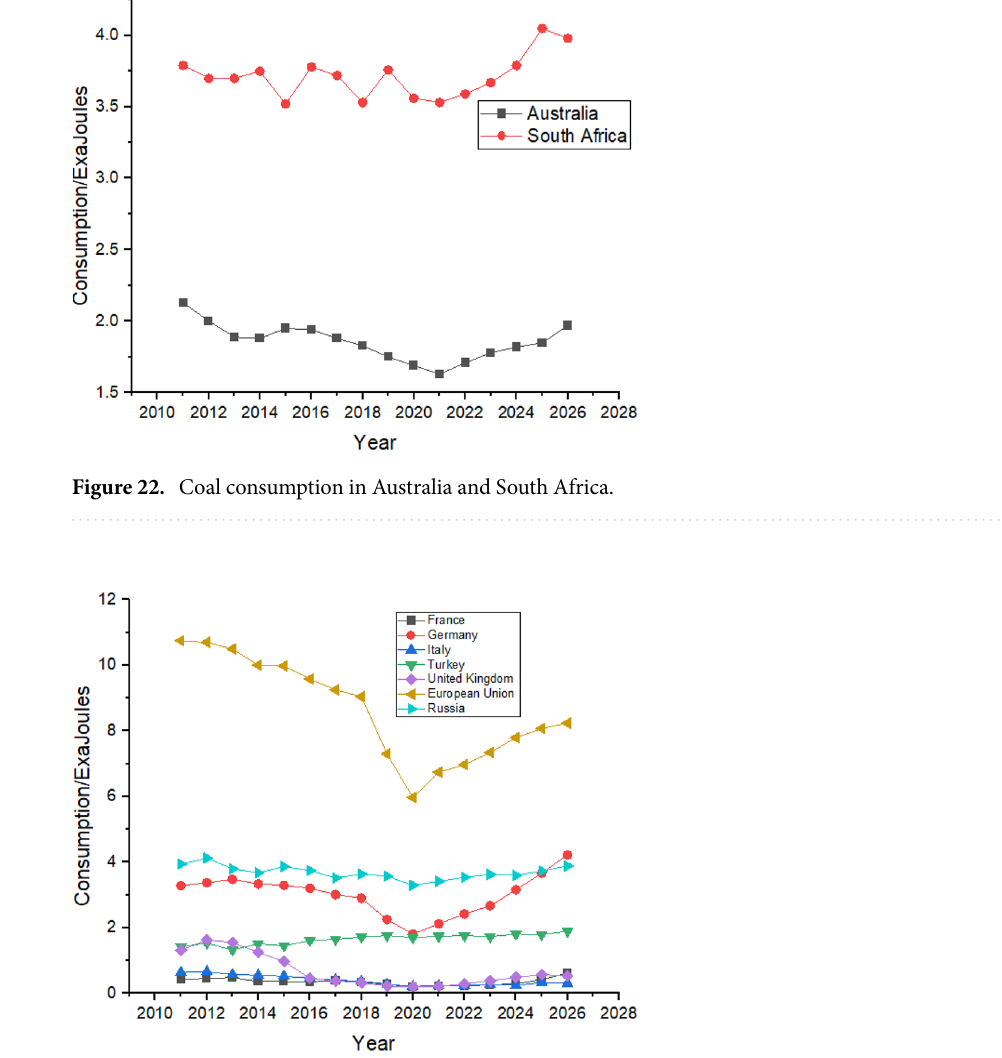
Figure 23. Coal consumption in European